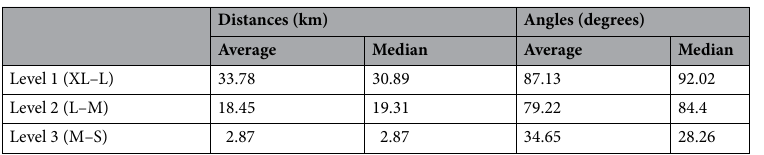
Table 1. Descriptive statistics of distances (km) and angles (degrees) between settlements of different size classes in the Punjab of N-India.